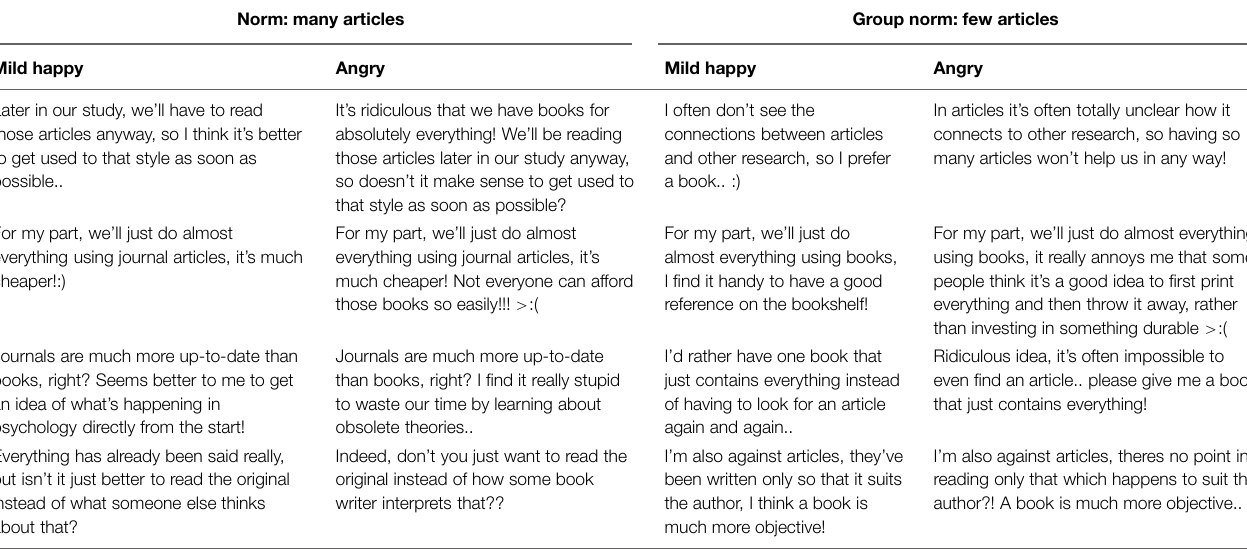
TABLE 2 | Example statements sent by the simulated group members during the simulated group interaction (Study 1). Norm: many